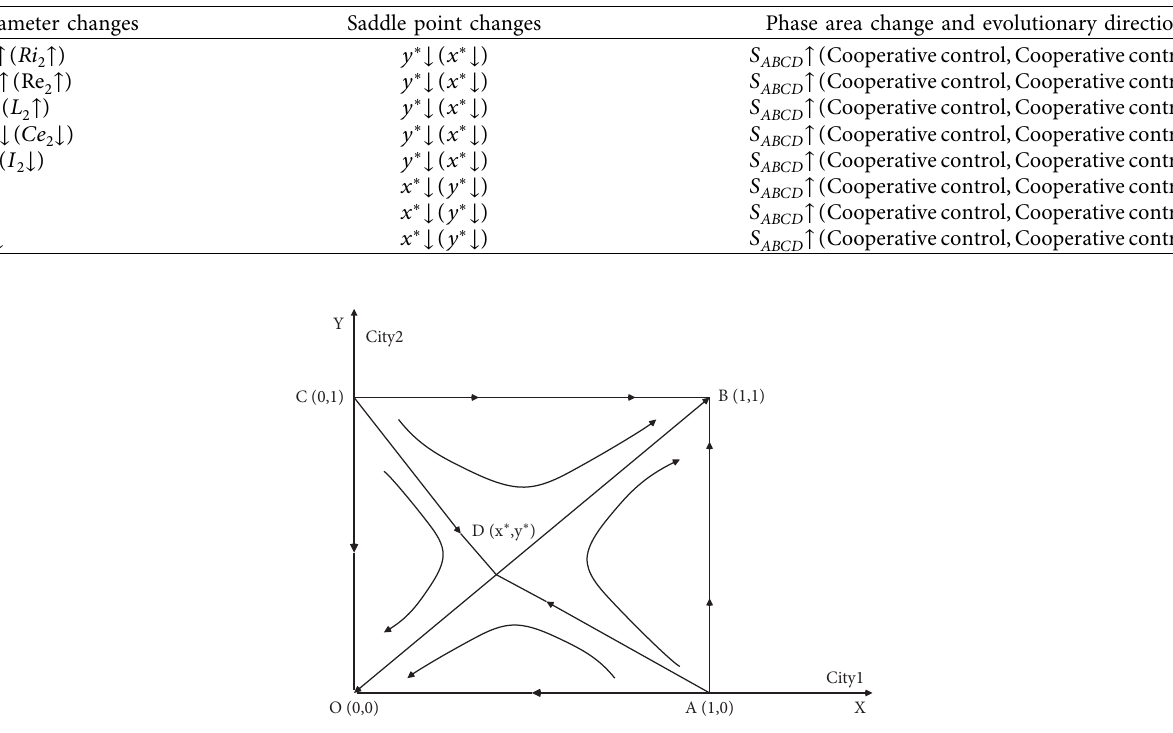
Table 4: Effect of parameter changes on evolutionary games without constraints.